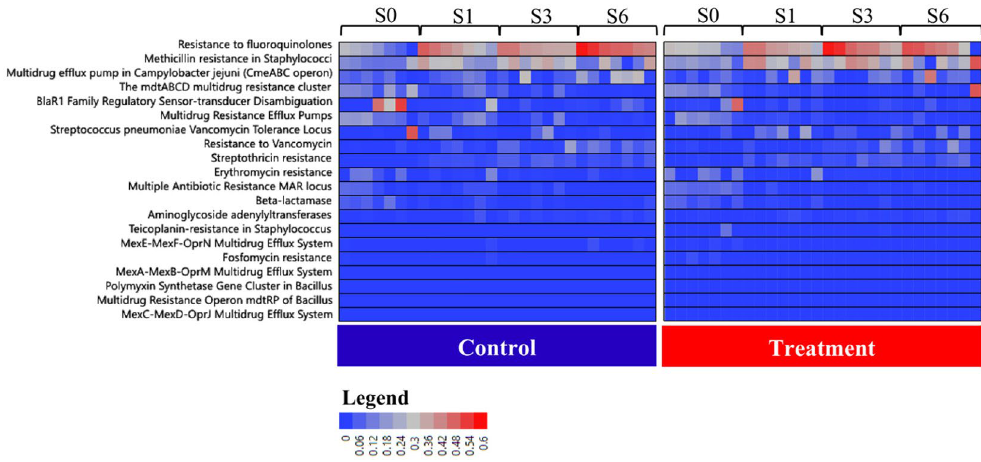
Figure 3. Heatmap displaying the distribution of the top 20 resistance to antibiotics and toxic compounds (RATC) functions. Results for samples collected at weeks S0, S1, S3 and S6 by treatment group for each individual fecal sample. Blue to red scale represents relative abundance for each function.